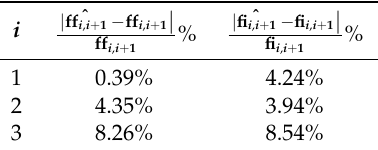
Table 5. Relative percentage error for each estimated